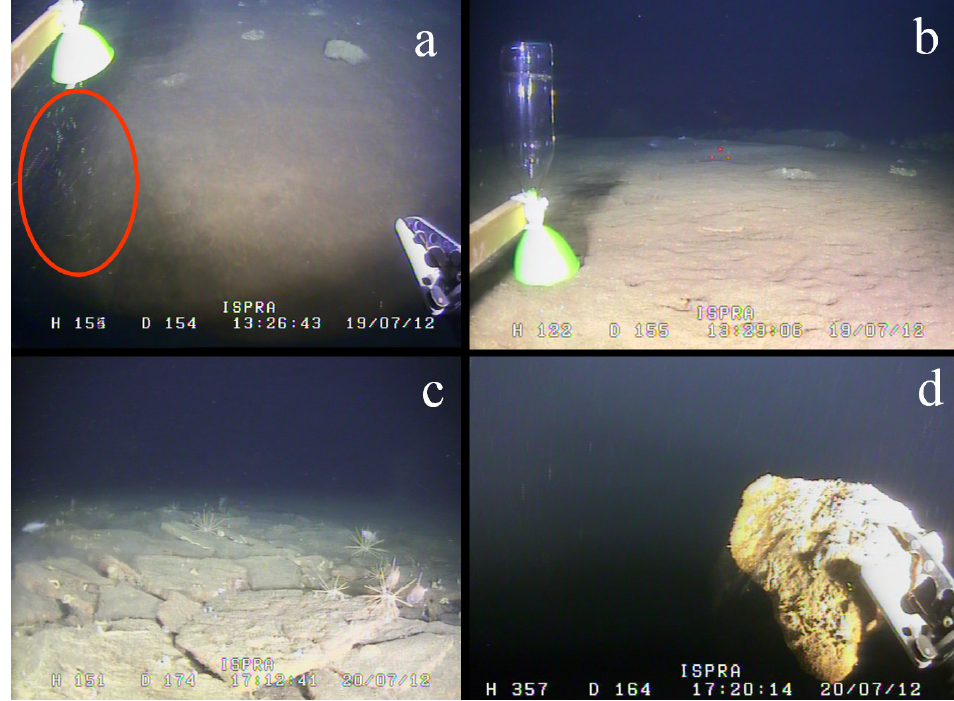
Figure 9. Some pictures showing the different phases of gas bubbles (a and b) and seafloor (c and d) sampling by using the ROV. For loca- tion of samples see Figure 6.